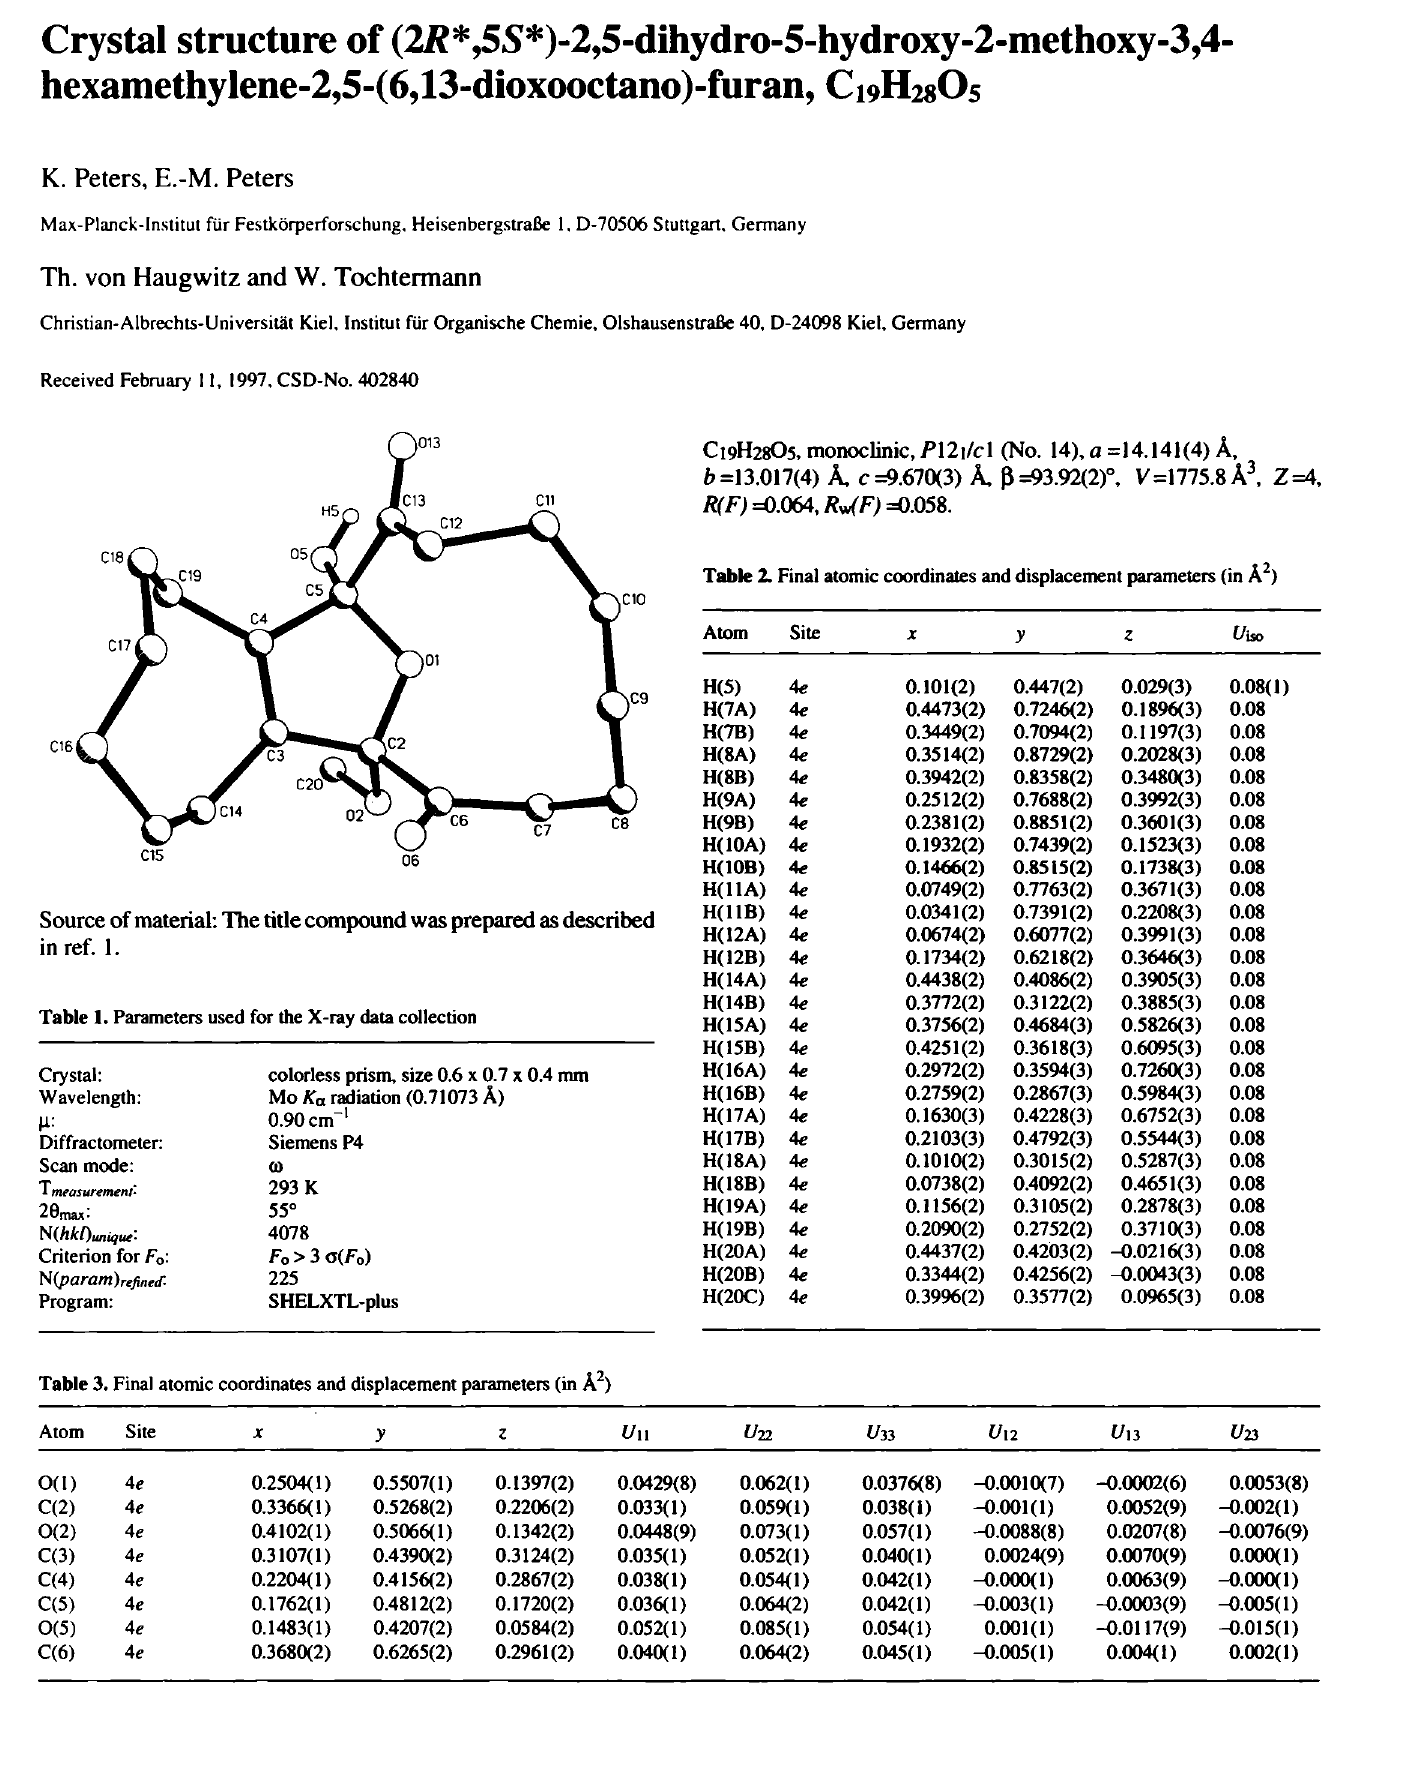
Table 2. Final atomic coordinates and displacement parameters (in